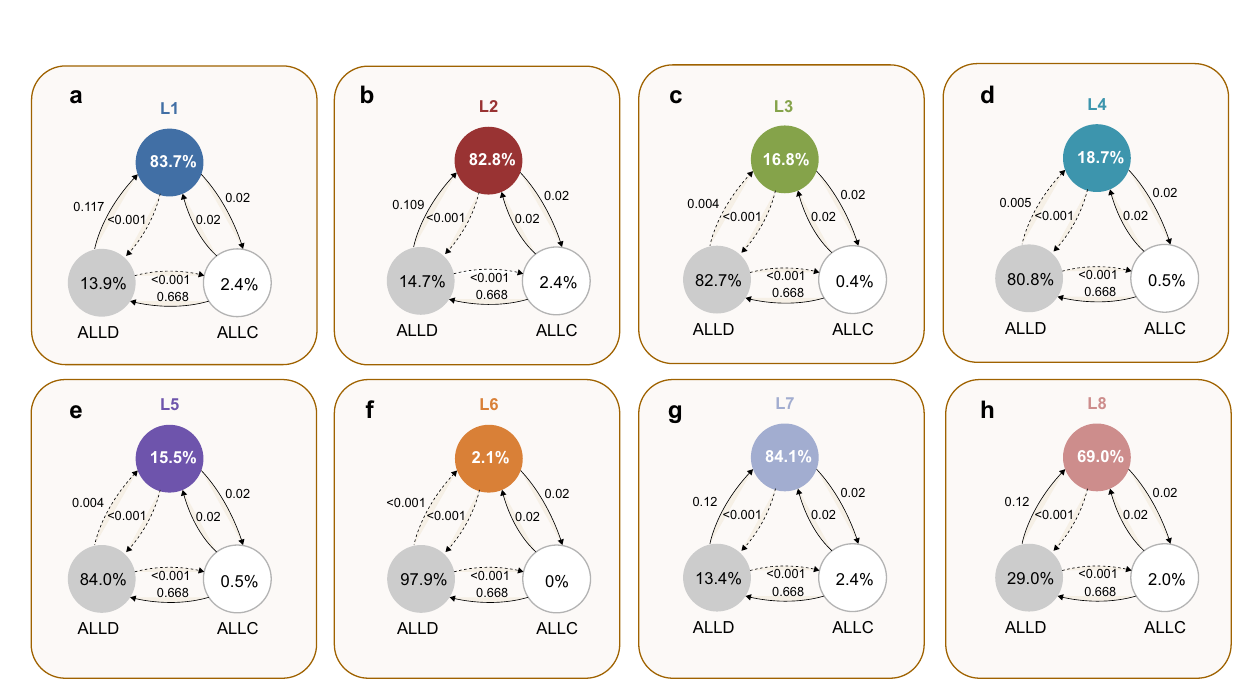
remainingfouroftheleadingeightnorms. b Whenweconsidertheaveragenumber of defections thatoccur beforerecovery, wesee thatthis numberdecreases asthe populationsizegrowslarge.Forsuf fi cientlylargepopulations,nodefectionoccurs before recovery. Simulations are averaged over 10,000